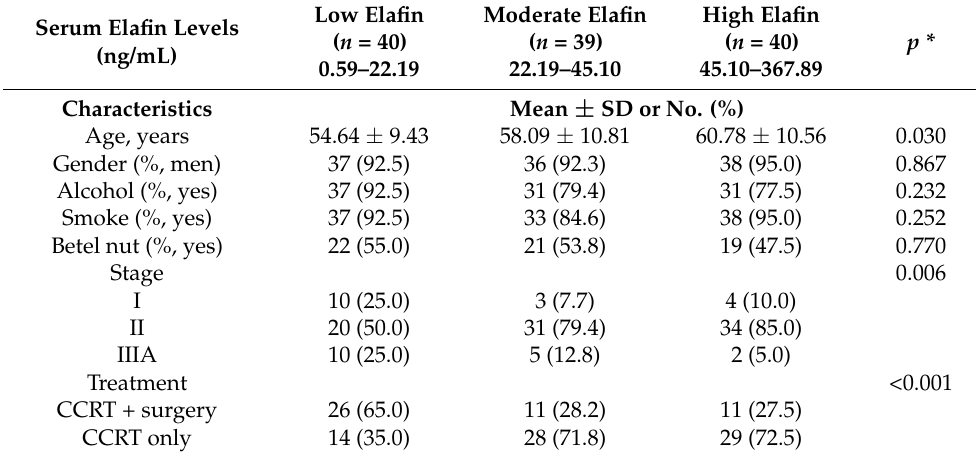
Table 2. A comparison of demographic and clinical parameters categorized by tertile of serum elafin levels.